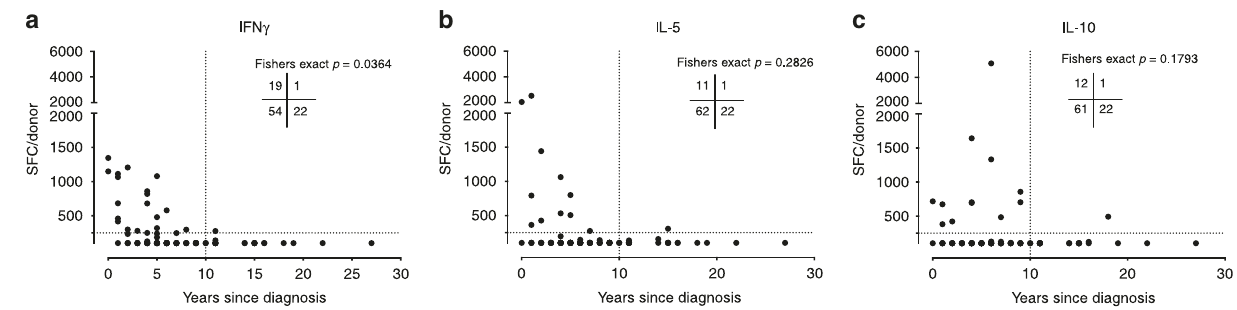
Fig. 4 Correlation between individual cytokine responses and time since diagnosis. Cohorts 1 and 2 combined ( n = 96 PD patients). The Y -axis shows the magnitude of responses a IFN γ , b IL-5, and c IL-10, against the α -syn peptide pool as SFC per 10 6 cultured PBMC. The X -axis shows the years since PD diagnosis. Each point represents one donor. Because many participants showed no response, there are overlapping points at the limit of detection (100 SFC). The number of patients in each quadrant is indicated in each graph. Two-tailed Fisher ’ s